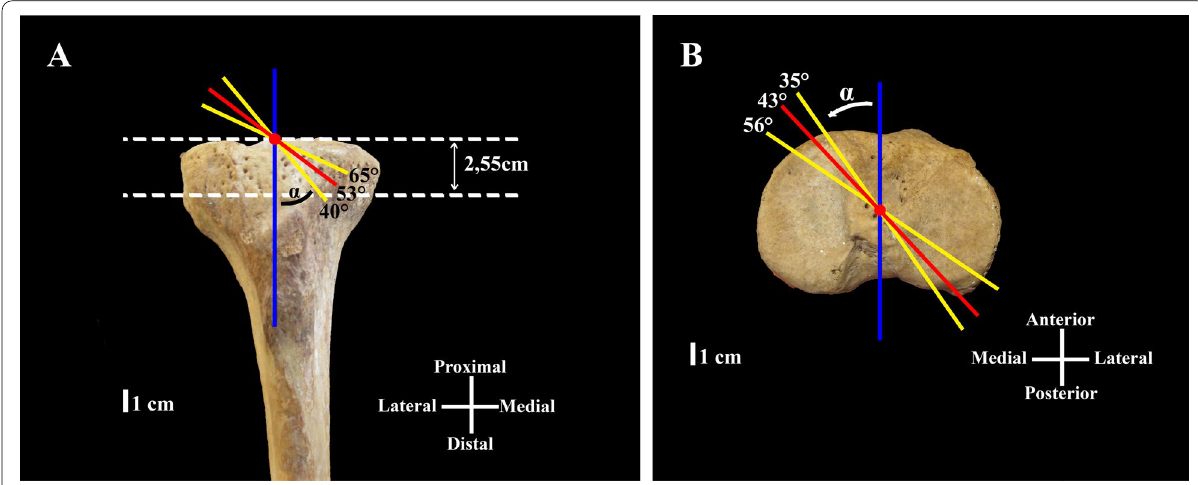
Fig. 2 Schematic representation of recorded measurements on dry bone. A . Coronal angle (CAT ATT ) minimum, maximum, and mean value, tunnel-plateau distance (DTTP) mean. B . Transverse angle (TAT ATT ) minimum, maximum and mean value